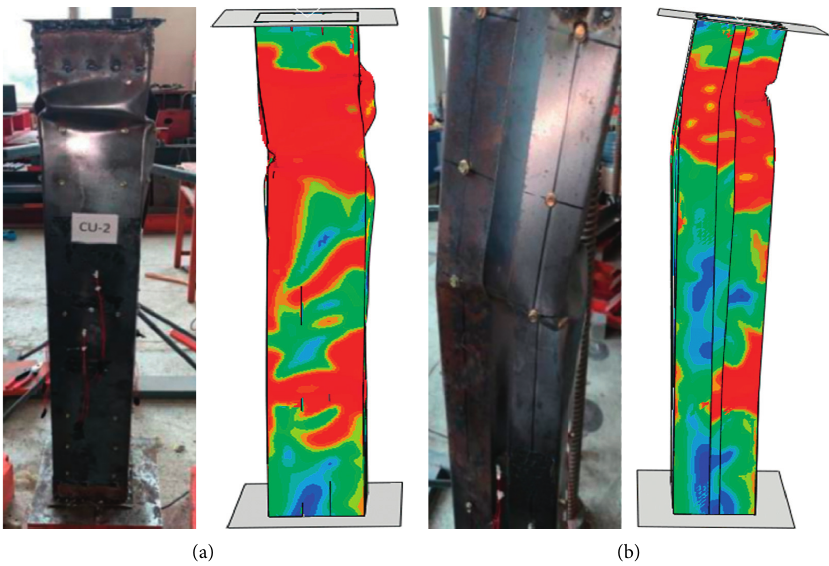
Figure 35: CU-type failure mode: (a) front elevation and (b) side